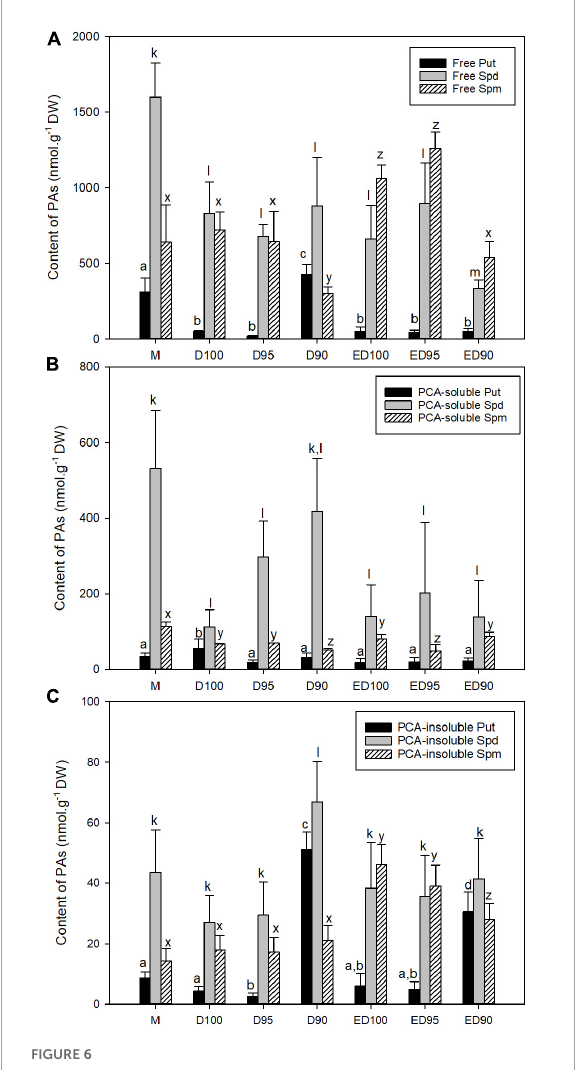
FIGURE6 The content of free PAs (A) , PCA-soluble PAs (B) , and PCA-insoluble PAs (C) in mature embryos (M), control embryos at half (D100) and at the end (ED100) of treatment with 100% relative humidity, and embryos exposed to 95 and 90% relative humidity during the first half of desiccation (D95 and D90) and subsequently transferred to 100% relative humidity (ED95 and ED90). Values are given as means ± standard deviations. Bars represent standard deviations of four independent experiments ( n = 8). Different letters indicate a statistically significant difference at p ≤ 0.05. a,b,c,d - Put forms; k,l,m - Spd forms; x,y,z - Spm forms.